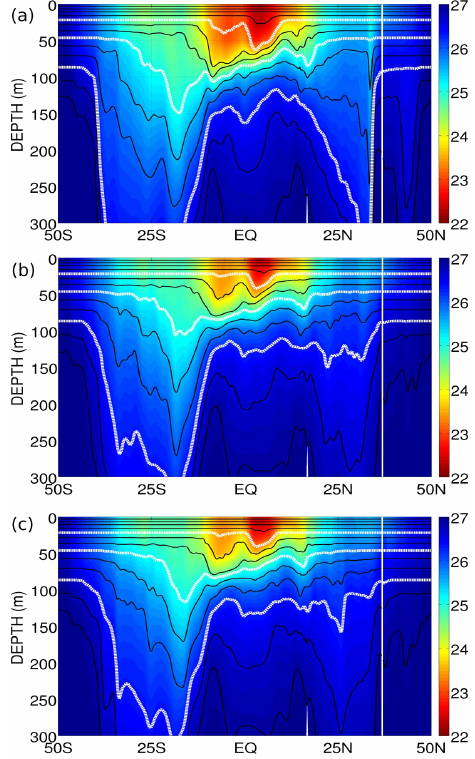
Figure 6. Potential density (kgm − 3 ) and the position of the layer interfaces along 25 ◦ W in the upper 300m for the (a) CTL run and the prior state of the (b) ASSIM and (c) VL_DPTS runs from 1 Jan- uary 2010 to 31 December 2012. The white dashed lines represent the interface between the 5th and the 6th, between the 8th and the 9th, and between the 11th and the 12th isopycnal layers, from top to